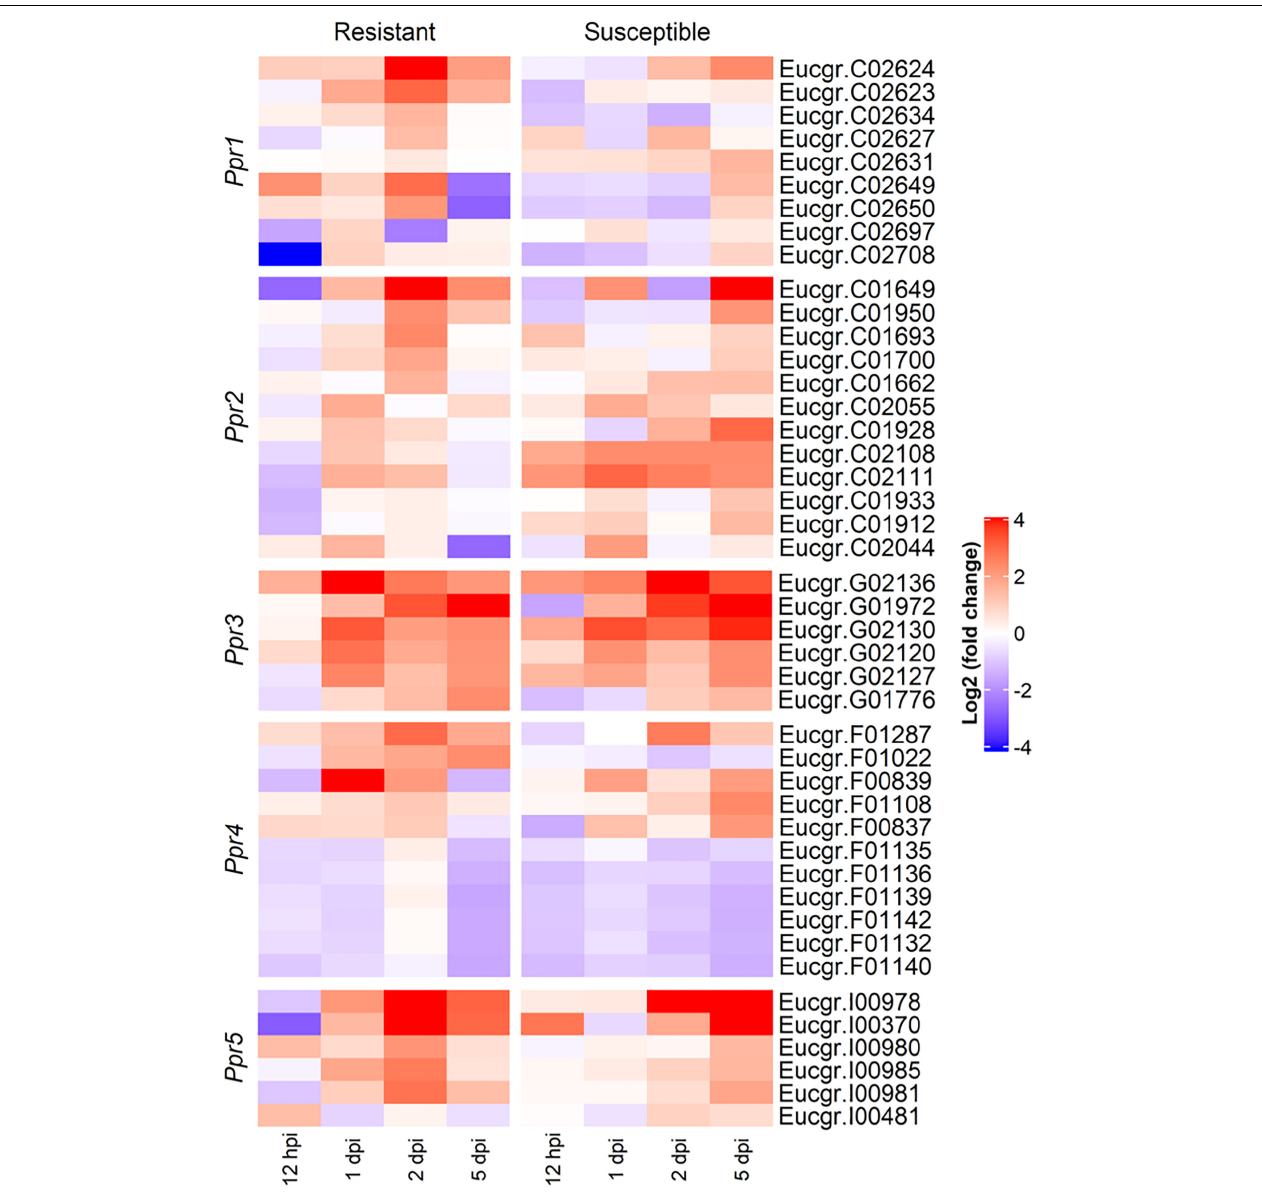
FIGURE 6 | Heatmap showing the expression profiles of differentially expressed R (resistance) genes underlying the Austropuccinia psidii resistance loci in the R- and S-interactions over time, where red and blue represent up- and down-regulated genes, respectively. Heatmap shows log 2 (fold change) with p < 0.001 representing significant